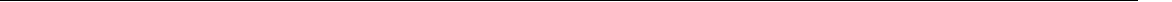
Fig. 6 IRAK-M KO and PIN1 KO dramatically reduce lung in fl ammation upon IL-33 treatment in vivo. a Representative H&E, PAS staining of lung sections from various treated mice, as well as BALF cytospin from the treated mice stained with Giemsa stain ( n = 5). Scale bar = 50 µ m. b Histopathology score- All H&E and PAS histological samples were examined and scored in a blind manner by the core facility pathologist ( n = 5). c ELISA measurements of IL-33, -5, -13 and IL-4 in the BALF of the mice treated with PBS or IL-33. d RNA was obtained from the whole lung tissue and analyzed for the relative expression of Il6 , Csf3 , Cxcl2 and Ccl5 by qRT-PCR. e CD11c + CD11b + CD205 + cells were monitored after PBS or IL-33 challenge in the indicated mice ( n = 3). In WT mice there was a 3-fold induction (P < 0.05) in CD11c + CD11b + CD205 + cells upon IL-33 treatment. PIN1 KO mice showed a more moderate increase and IRAK-M KO mice showed non signi fi cant (NS) increase in the CD11c + CD11b + CD205 + cells upon IL-33 treatment. The data were analyzed by a Student ’ s two-tailed t test and the values are reported as mean ± standard errors of the means (SEM). *- statistical signi fi cance ( P < 0.05), **- signi fi cance ( P <